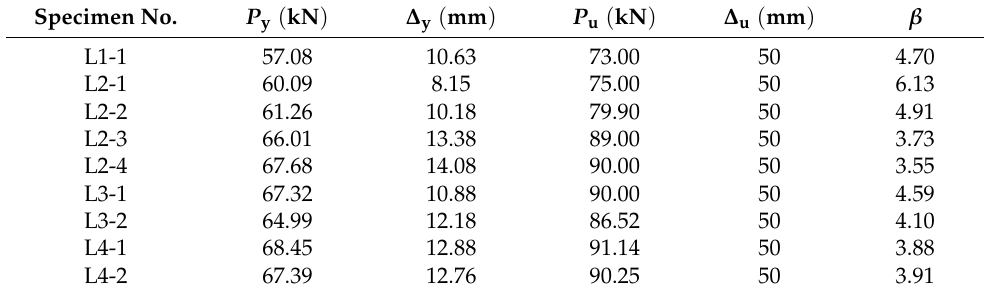
Table 5. Mechanical properties test data of specimens.